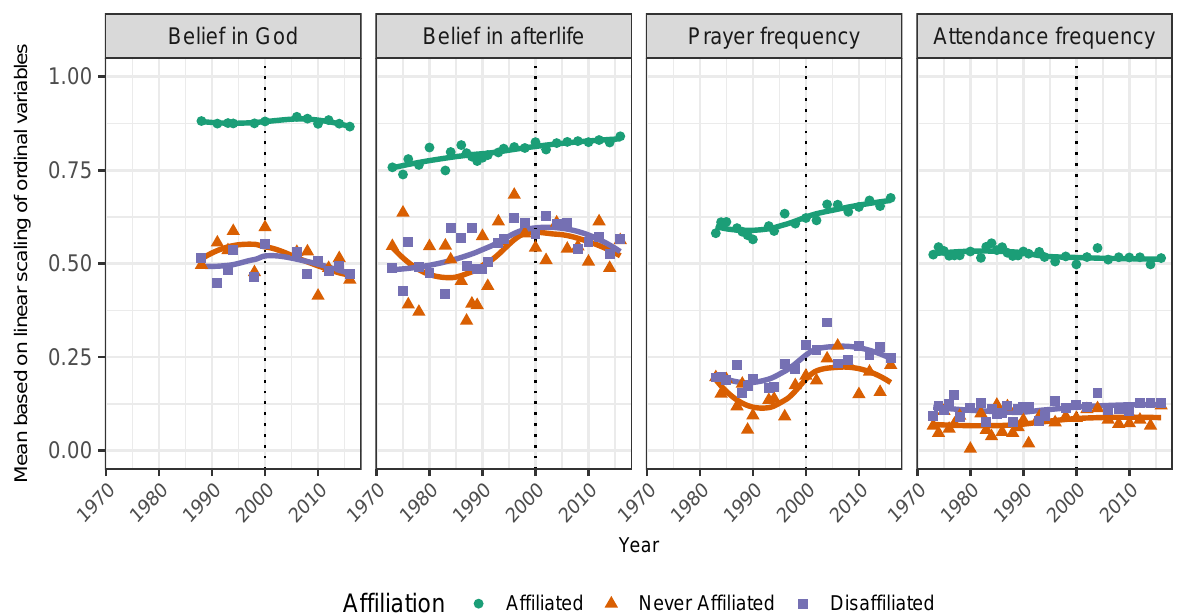
Figure 6: Trends in religious beliefs and practices among the religiously affiliated, the disaffiliated, and the never affiliated in the General Social Survey. All ordinal questions are treated as a linear quantitative scale with a maximum of one and a minimum of zero. All means are sample weighted. Smoothed trend lines are shown for each